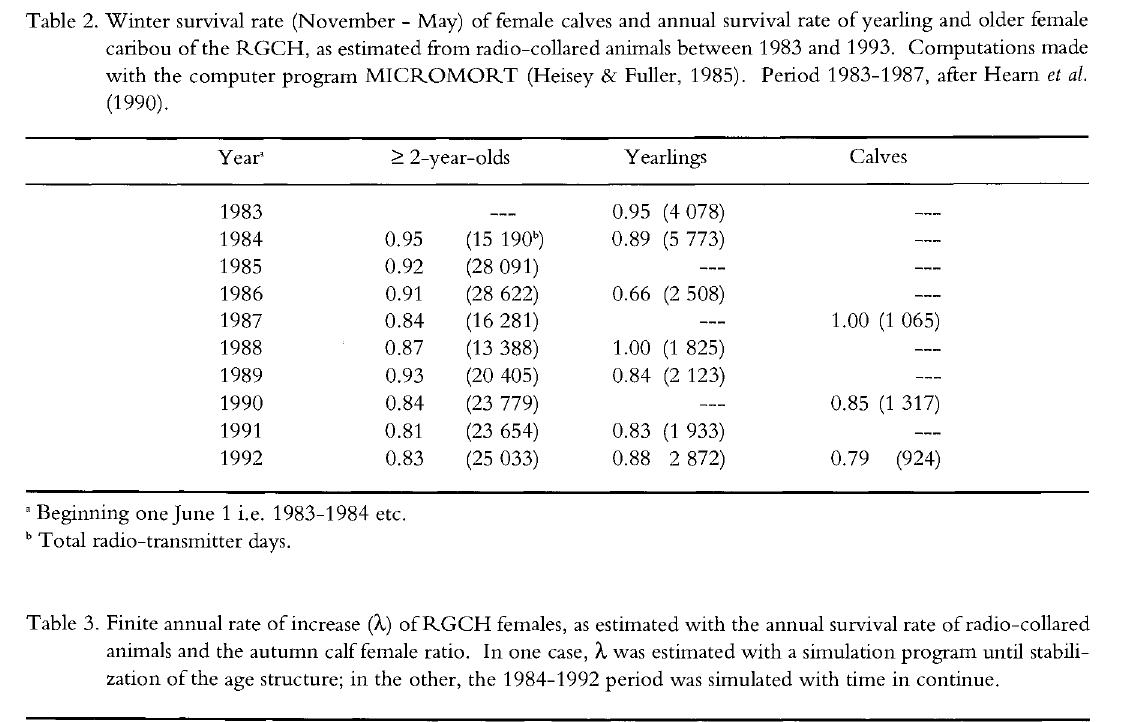
Table 2. Winter survival rate (November - May) of female calves and annual survival rate of yearling and older female caribou of the R G C H, as estimated from radio-collared animals between 1983 and 1993. Computations made with the computer program M I C R O M O RT (Heisey & Fuller, 1985). Period 1983-1987, after Hearn et al. (1990).